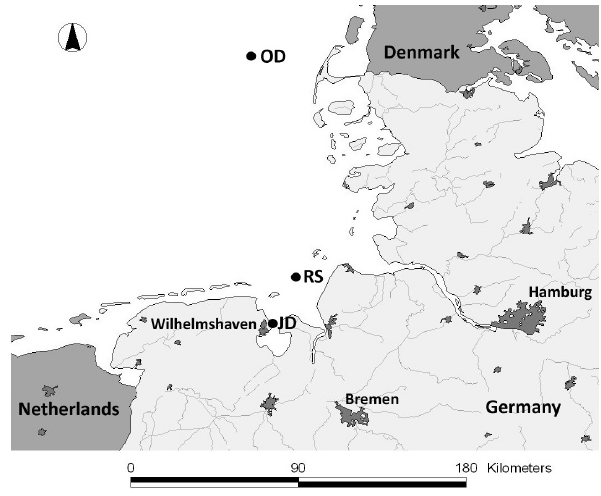
Figure 1. Map of the German Bight showing the sampling loca- tions of Mytilus edulis mussels from the offshore sites ODAS(OD; oceanographic data acquisition station), Jadebusen (JD), and Roter Sand (RS; after Brenner et al., 2009).